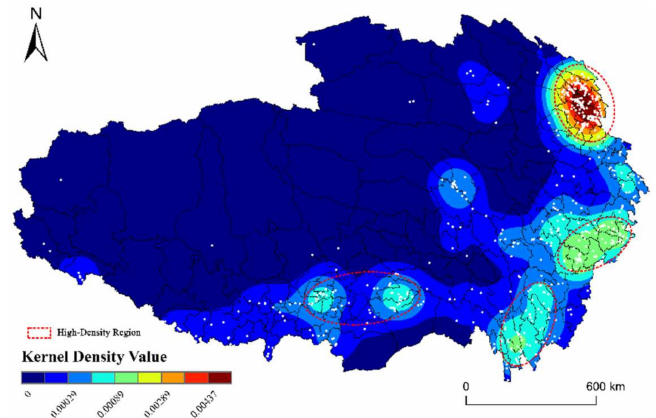
Figure 4. Kernel density map of RT villages in